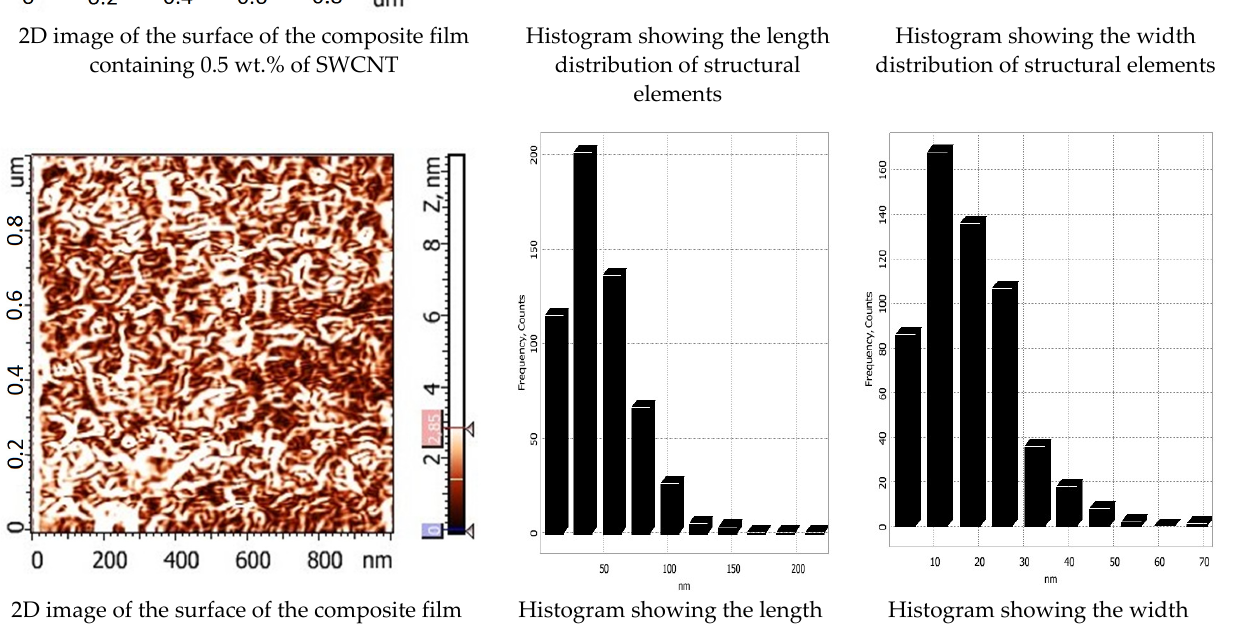
Figure 3. Two-dimensional images of surfaces of the composite films containing 0.1, 0.5, and 3.0 wt.% of SWCNT; histograms of length and width distributions of the structural elements. As indicated in Figure 3, chitosan macromolecules in the composite film containing 0.5 wt.% of carbon nanotubes are densely packed. These data are confirmed by the results of the SEM studies of the structure of the composite films (Figure 4). The dimension range of the observed structural elements (length: 10–140 nm, width: 5–50 nm) is nar- rower than that found for similar films containing 0.1 and 3.0 wt.% of SWCNT (length: 25–300 nm, width: 10–80 nm). ( а )